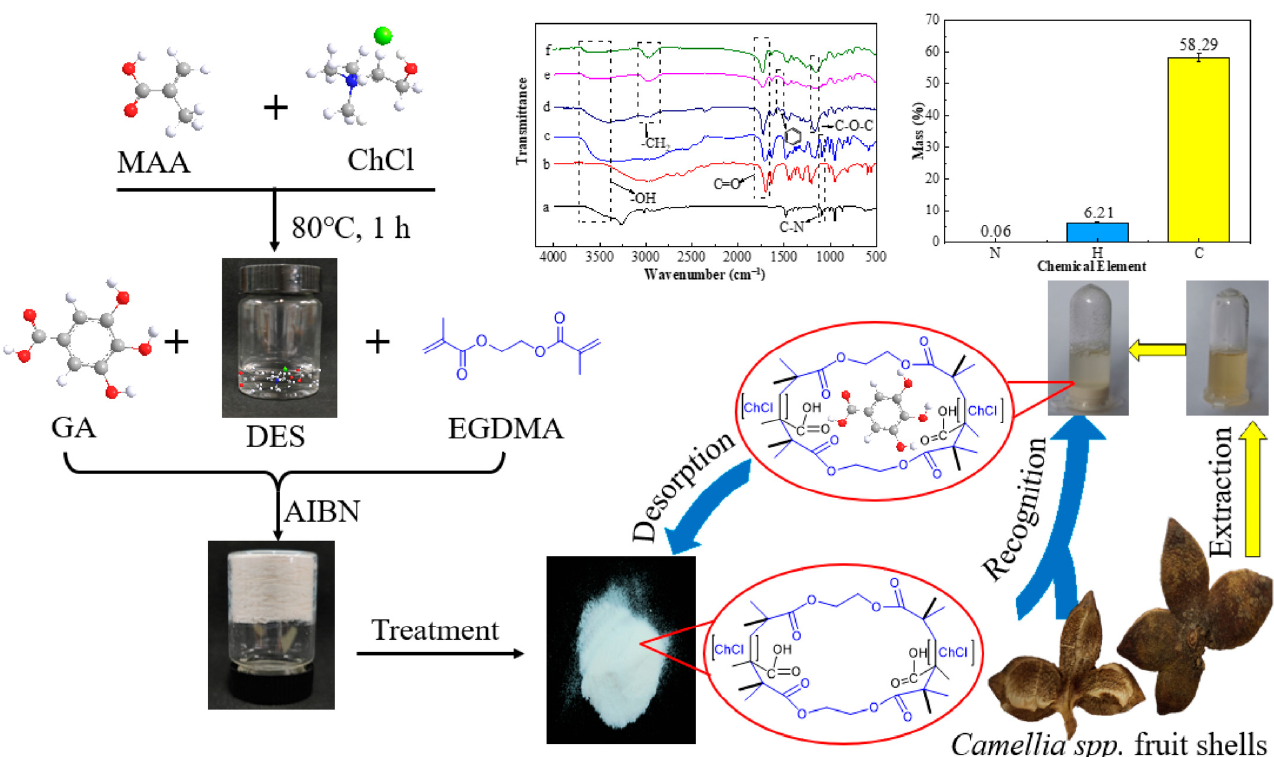
Figure 1. The schematic process for DES@MIPs’ preparation and characterization, and their utilization for purification of gallic acid from Camellia spp. fruit shells .